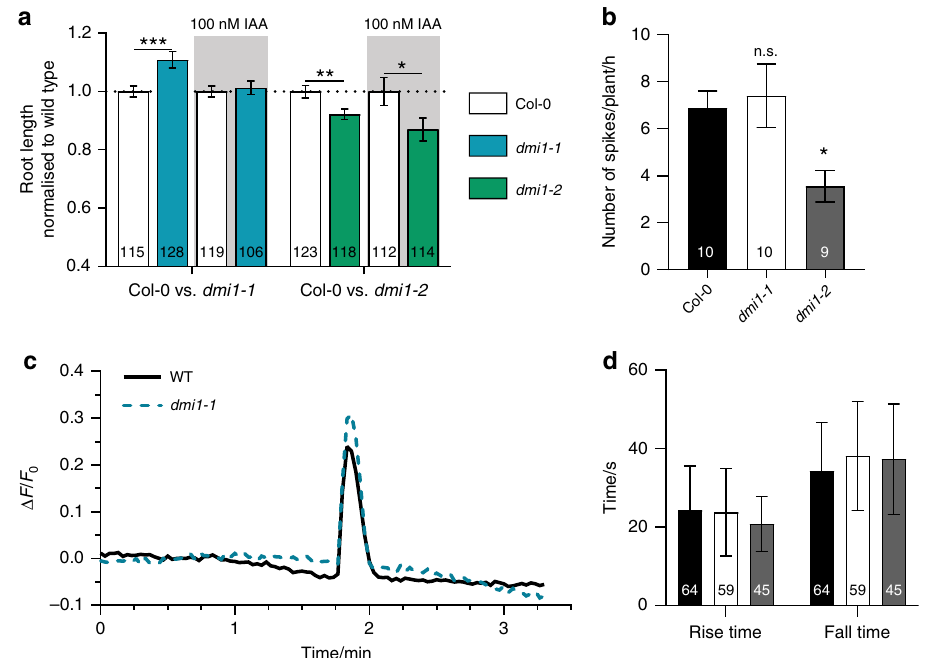
Fig. 3 Auxin complements the root length and Ca 2 + signature phenotype of dmi1-1 . a Primary root length quanti fi cation of wild type (Col-0), dmi1-1 , and dmi1-2 grown in the absence or presence of 100 nM of indole-3-acetic acid (IAA) 6 days after germination (dag). The data represent three biological replicates. Values were normalised to wild type grown under the same conditions and represent means ± s.e.m. Numbers in bars denote sample size ( n ). * p < 0.05, ** p < 0.01, *** p < 0.001 (two-tailed t test with a prior F -test for homoscedasticity). b Number of Ca 2 + spikes per plant during 1 h of imaging at 2 h after gravitational stimulus in Col-0, dmi1-1 , and dmi1-2 bent side (high auxin), 5 dag. Values are means ± s.e.m. Numbers in bars represent the total of plants imaged ( n ). n.s. not signi fi cant, * p < 0.05 (one-way ANOVA with Dunnet ’ s multiple comparison test vs. Col-0). c Representative nuclear Ca 2 + trace recorded in the bent side (high auxin) of Col-0 and dmi1-1 . Signals were aligned by their maxima. d Rise and fall times of the Ca 2 + spikes detected in the bent side (high auxin) of Col-0, dmi1-1 , and dmi1-2 . Values are means± s.d. No statistical differences were found (one-way ANOVA with Bonferroni ’